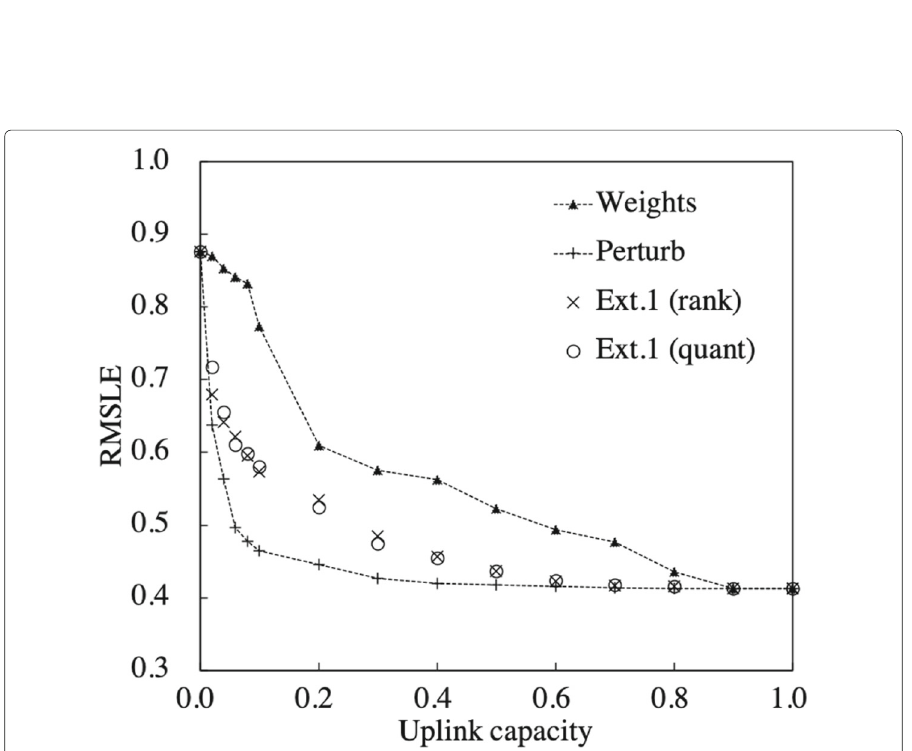
Fig. 8 Prediction accuracy (RMSLE) vs. uplink capacity obtained using MLP for prediction. Perturb, weights, or extension scheme 1 with ranking and quantizing was used for feature